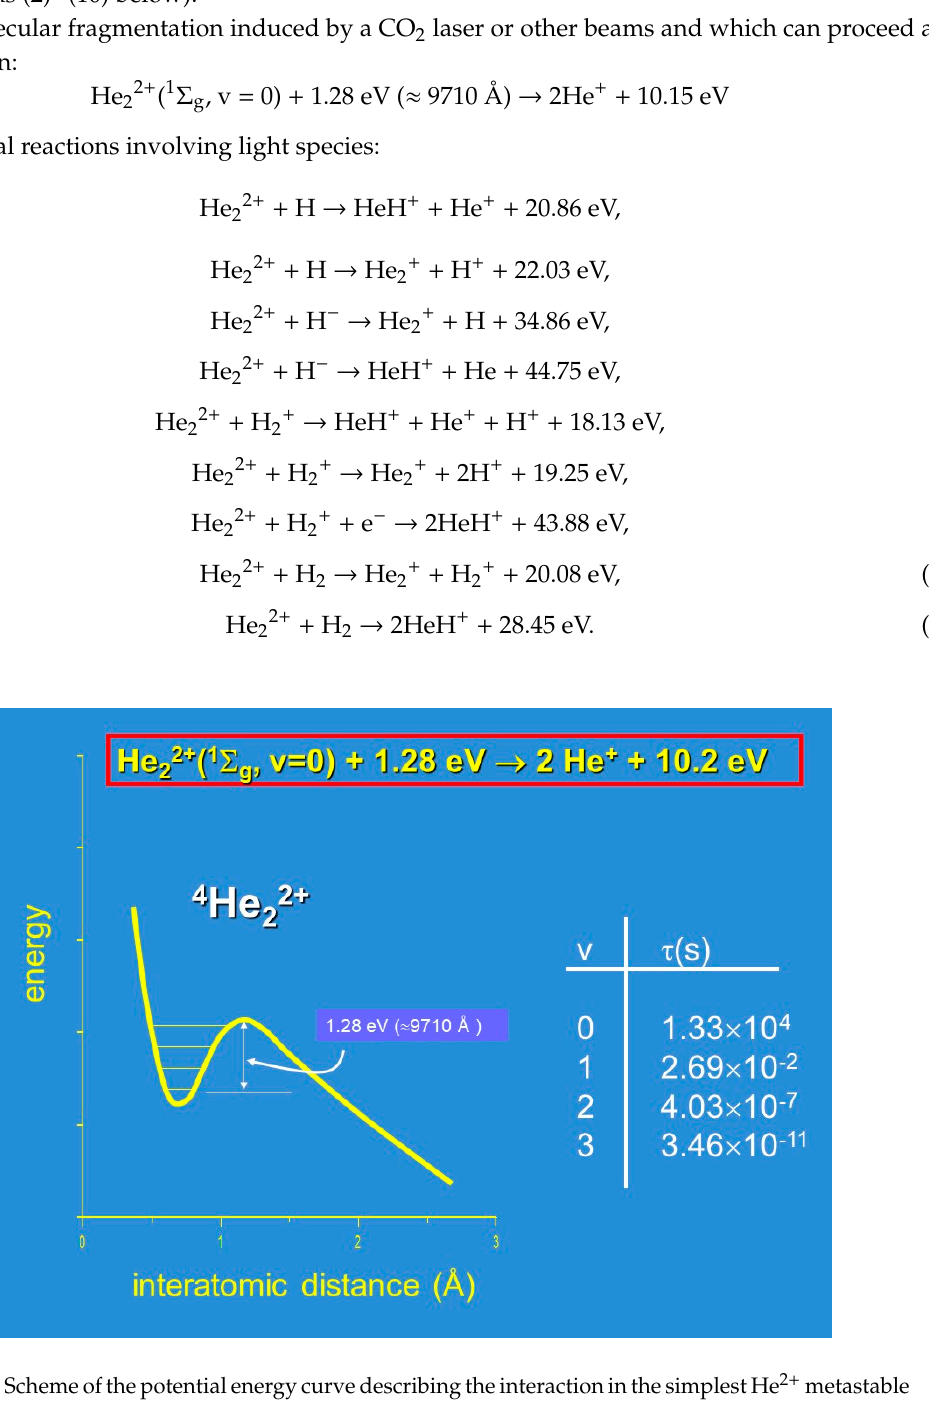
Figure 2. Scheme of the potential energy curve describing the interaction in the simplest He 2+ metastable molecular dication studied first by Pauling in 1933 [18].